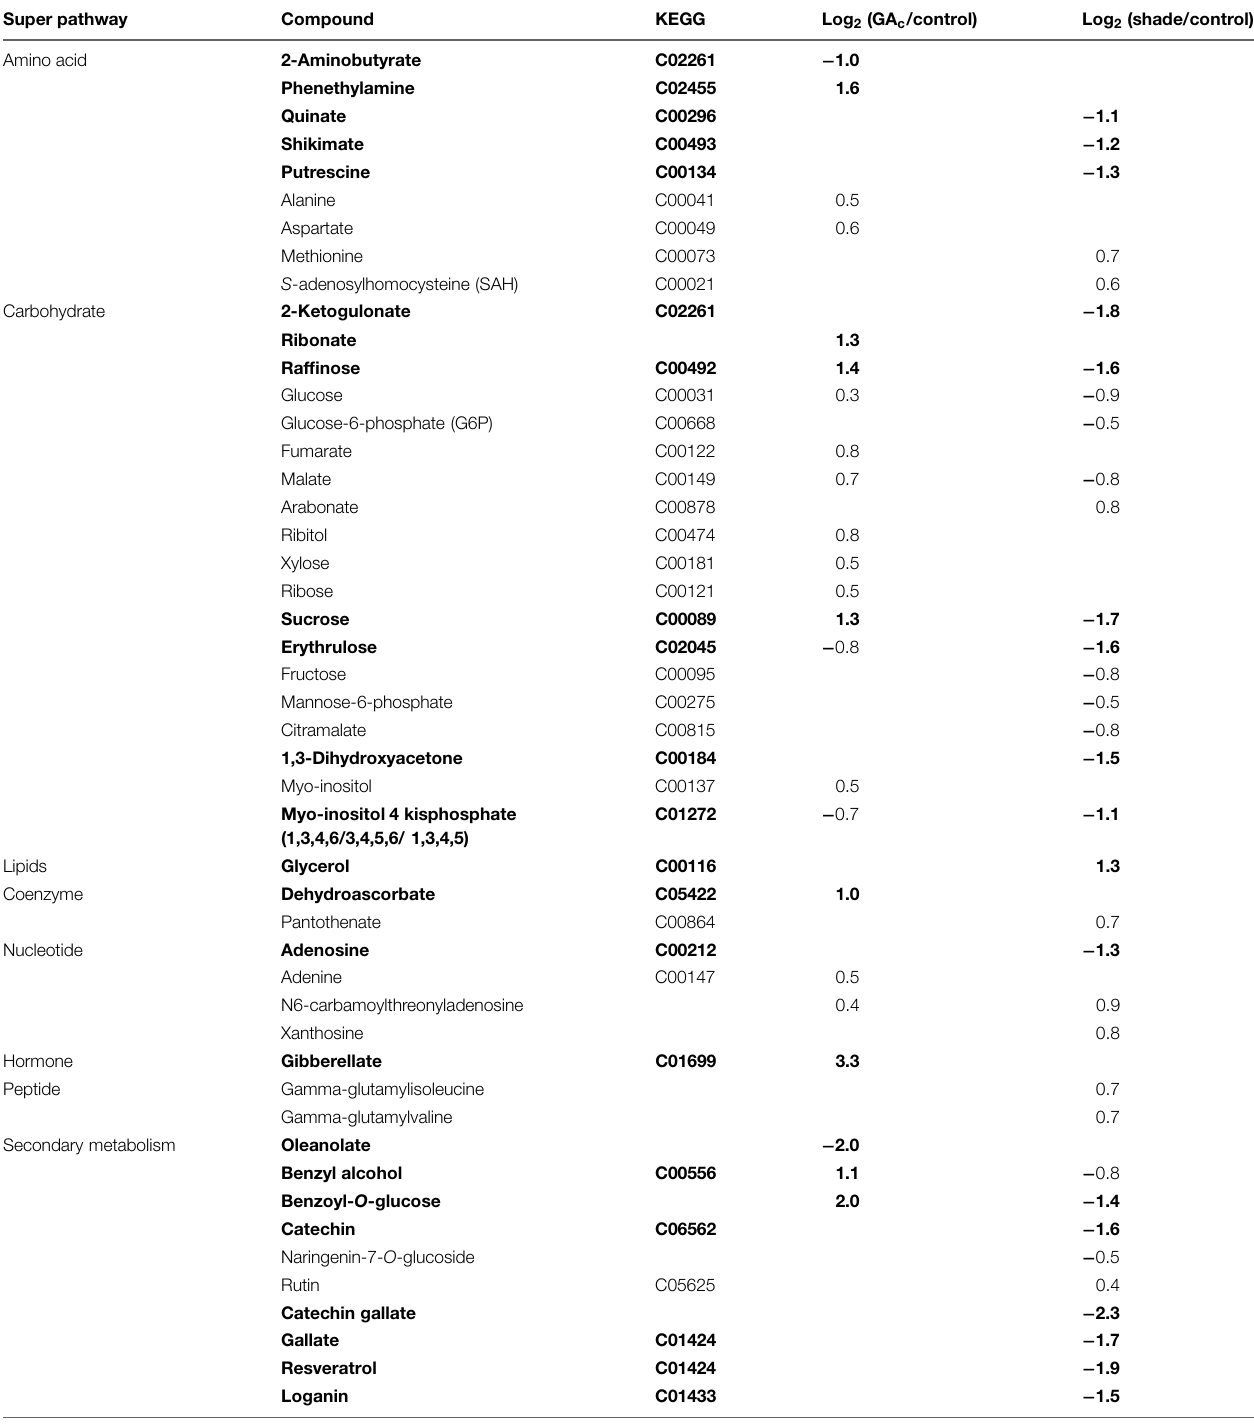
TABLE 3 | List of metabolites significantly affected by GAc and shade treatments ( P < 0.05), functional categories, KEGG compound number and respective fold-change. Super